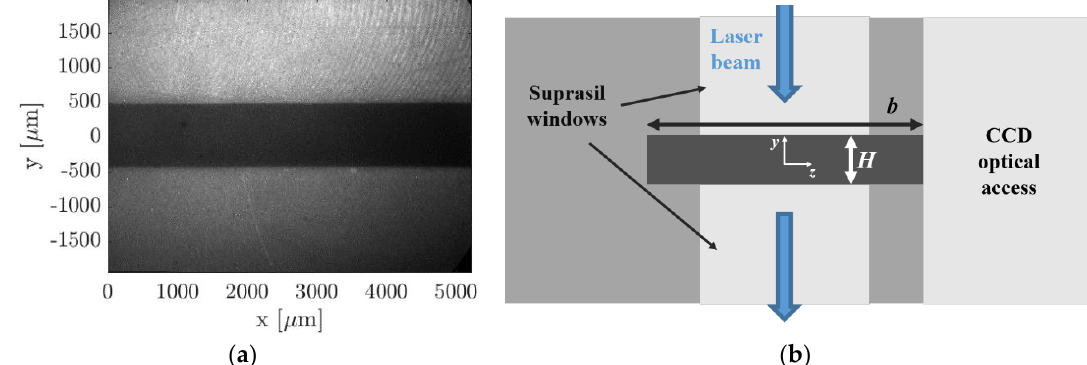
Figure 4. In ( a ), an image of the channel gap in the region of interest for MTV, recorded with the CCD. In ( b ), a sketch of the channel cross-section at the MTV test section. The upper and lower bright regions correspond to the Suprasil ® windows for the laser beam access. The bright region on the right represents the optical access for the CCD camera. The width of the cross-section and the distance between the Suprasil ® windows are indicated on the image as 𝑏 and 𝐻 , respectively.